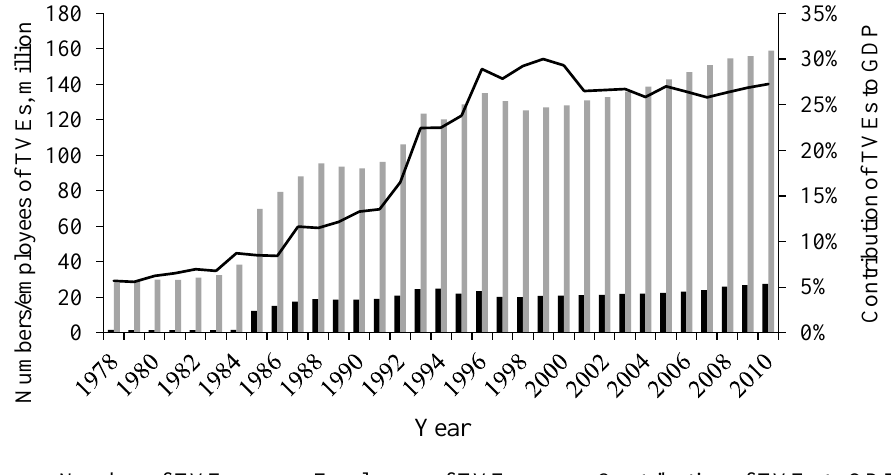
Figure 1. Number, employees, and contribution of township and village enterprises, 1978–2010 *. * Notes: The data were derived from the China Township and Village Enterprise Yearbook which stopped updating since 2011. Besides, private TVEs were not counted by the statistical system in the year 1985 and before.